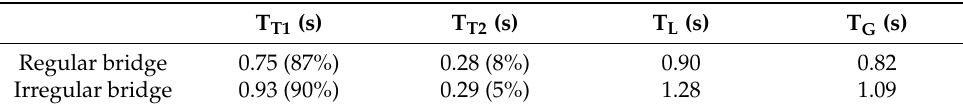
Table 1. The periods are computed using the effective stiffness of the columns. Table 1. Modal properties including periods and (effective modal mass Table 1. Modal properties including periods and (effective modal mass ratios).